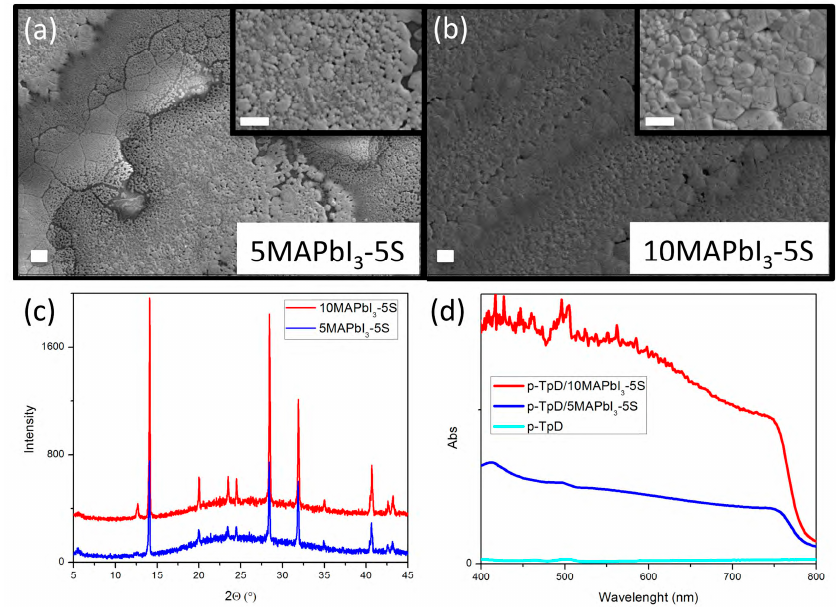
Figure 7. Scanning electron microscopy (SEM) images ( a , b ), X-ray diffraction (XRD) spectra ( c ), and UV-visible absorption ( d ) of 5MAPbI 3 -5S and 10MAPbI 3 -5S printed pattern film on glass/printed poly-TPD substrate. Scale bars 10 µ m.